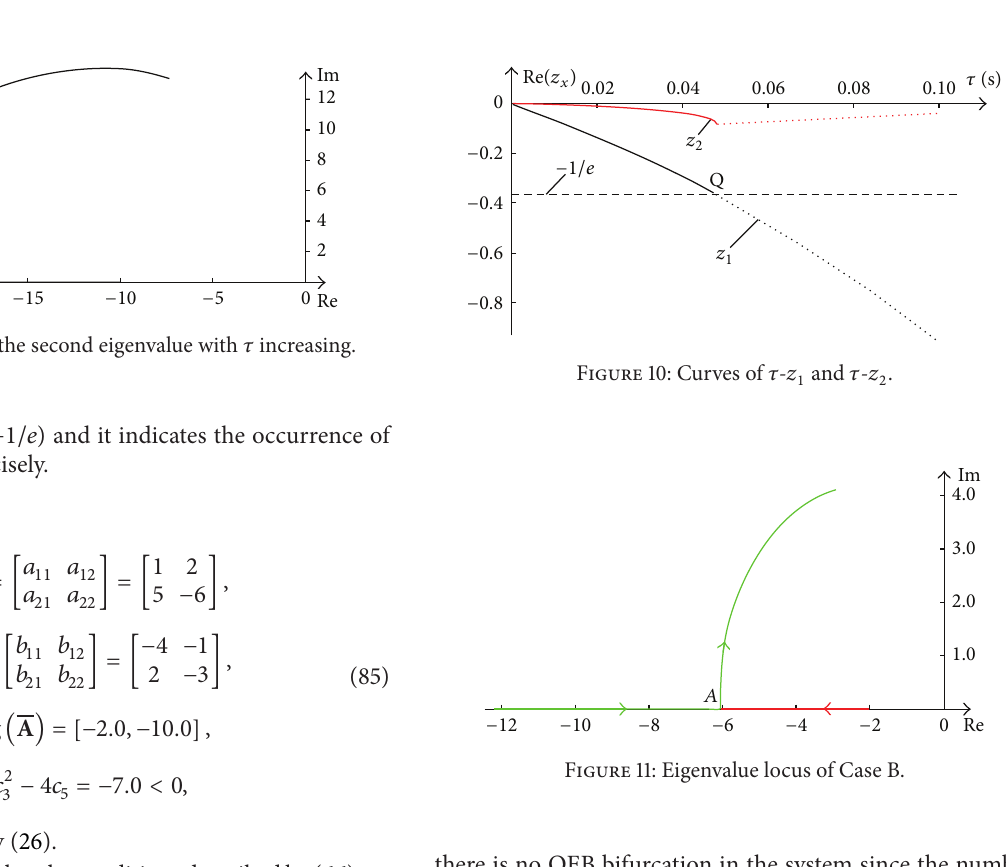
Figure 8: Simulation results with various 𝜏 values.